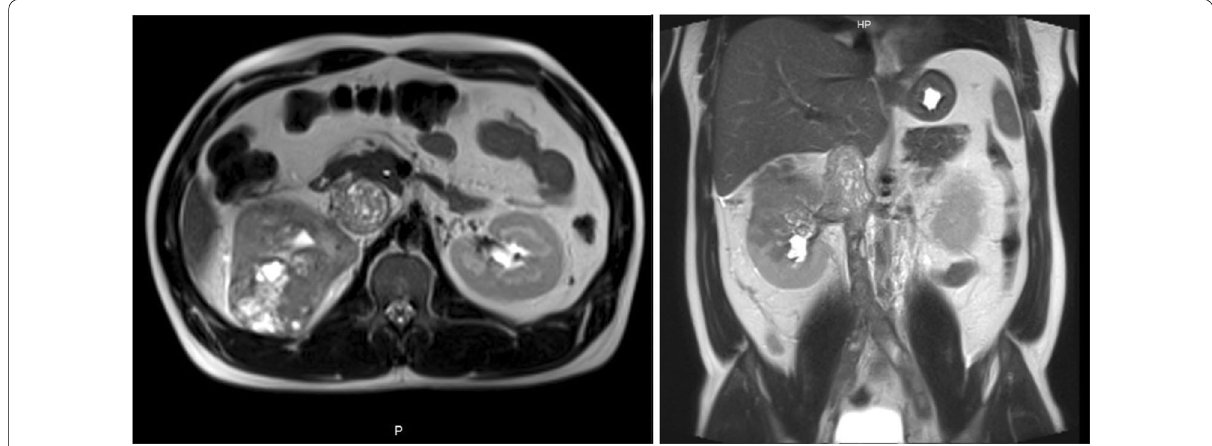
Fig. 1 T2 HASTE MRI images showing A the right upper polar tumor and the tumor thrombus in the IVC B the thrombus in the IVC and the distal extent in the iliac